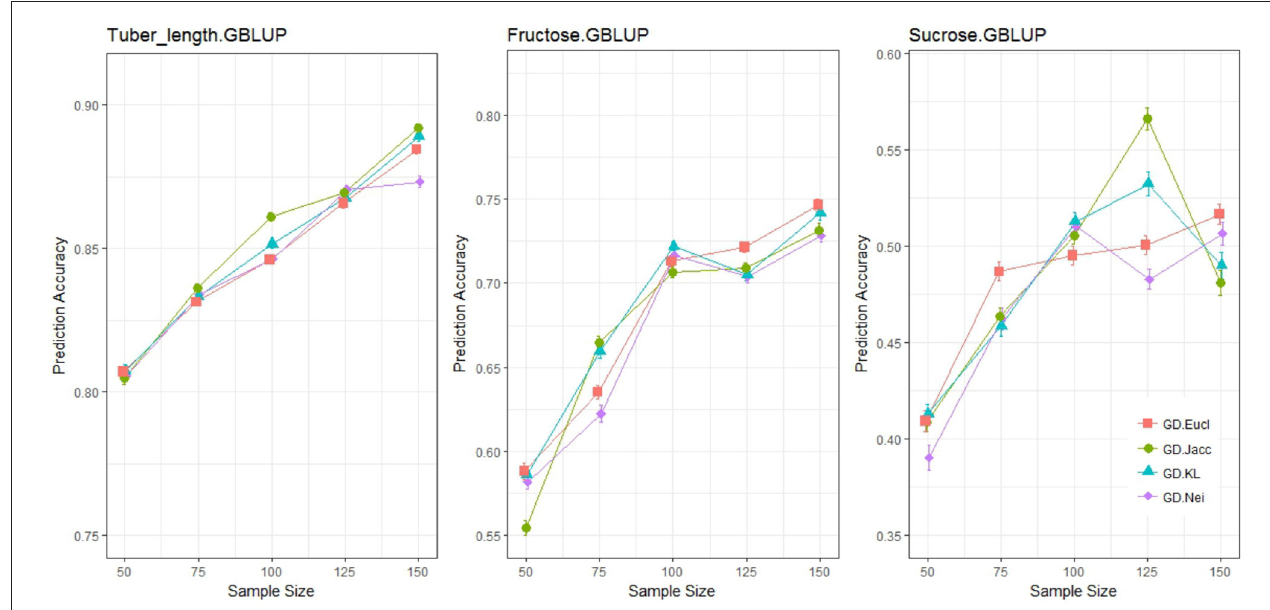
FIGURE 4 | Prediction accuracy under different distance measures for genetic distance sampling with a GBLUP statistical model. Each graphical window represents a different trait, with varying sample sizes on the x -axis and the outcome variable, prediction accuracy on the y -axis. The different colored lines represent different distance